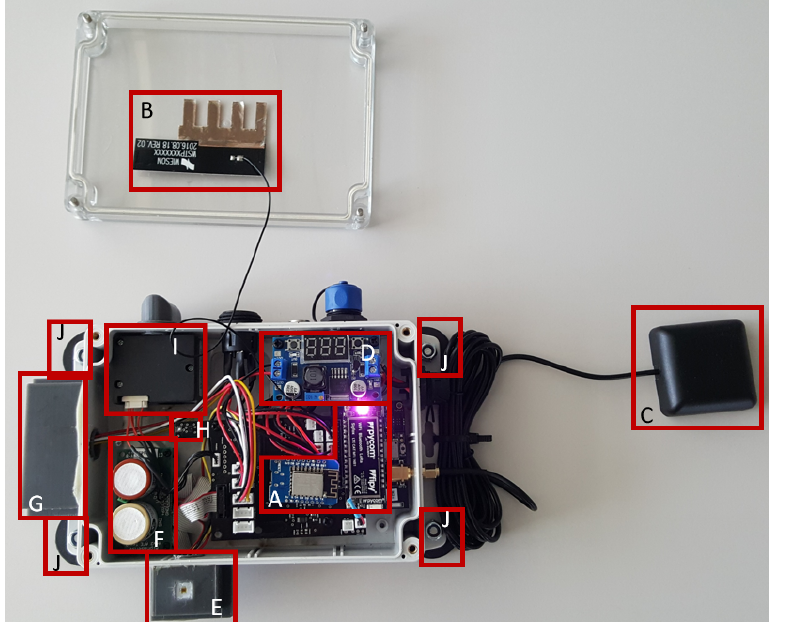
Figure 1. The sensor-box: ( A ) microcontrollers (FiPy; here ESP8266 instead of ESP32), ( B ) LTE antenna, ( C ) GPS antenna, ( D ) DC/DC converter, ( E ) Light sensor, ( F ) O 3 and NO 2 sensors, ( G ) Sound sensors, ( H ) Temperature/Humidity and TVOC/CO 2 sensors, ( I ) PM sensor, ( J )